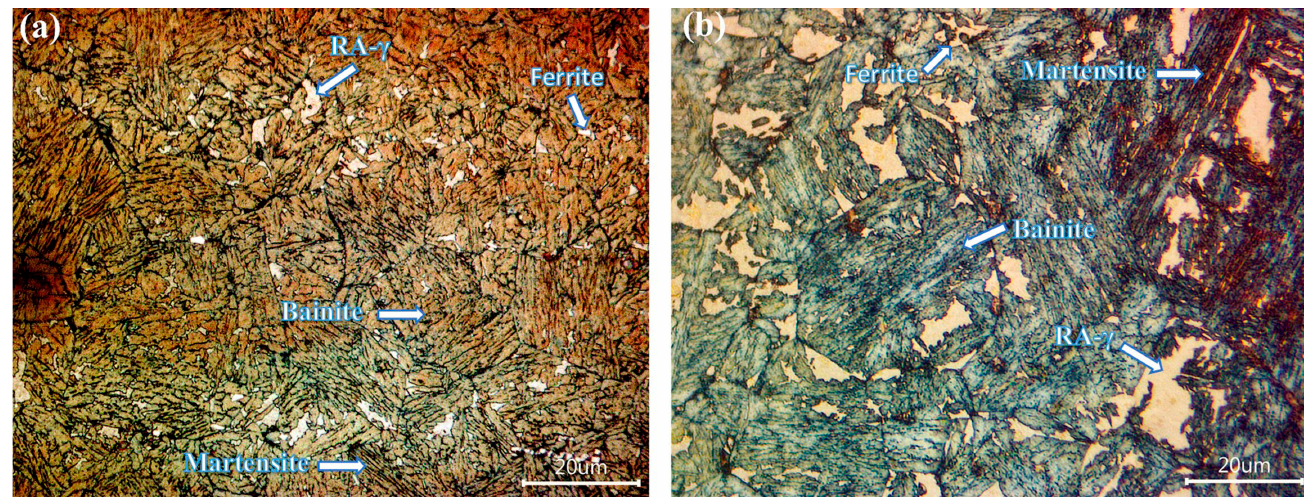
Figure 11. Q&P microstructure of ( a ) boron-free steel given the partitioning treatment P1 (CP-Q&P-B0-P1) and ( b ) boron-free steel given the partitioning treatment P2 (CP-Q&P-B0-P2). Optical microscope micrographs.